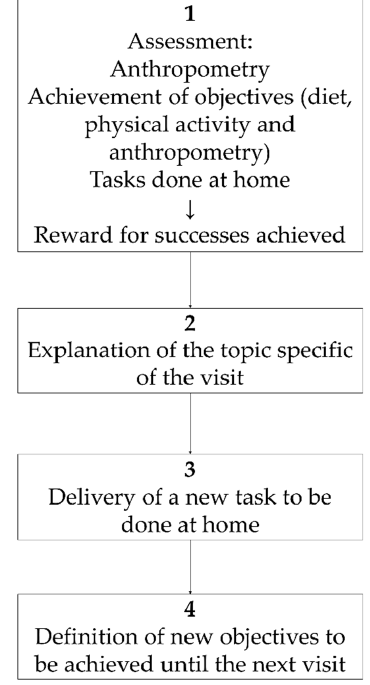
Figure 1. Obemat2.0 motivational interview structure within each visit.